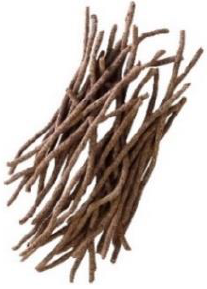
Figure 4. Best extruded product in this work.